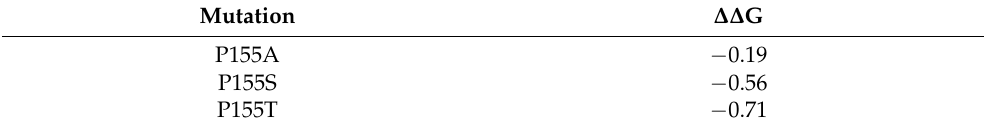
Figure 11. Differential scanning calorimetry (DSC) analysis on antibody stability. The dissolution temperature (Tm) of the WT, P155S, P155A, P155T were 59.32 °C, 62.43 °C, 62.73 °C and 62.36 °C, respectively. The dashed line shows the raw data, and the solid line shows the fitting curve.